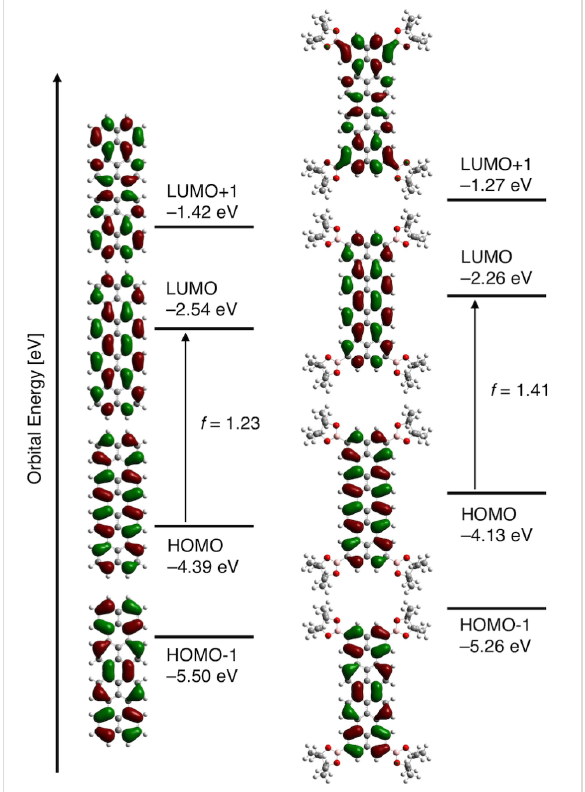
Figure 6: MO diagrams of terrylene and QB4 based on calculations at the B3LYP/6-31G(d).